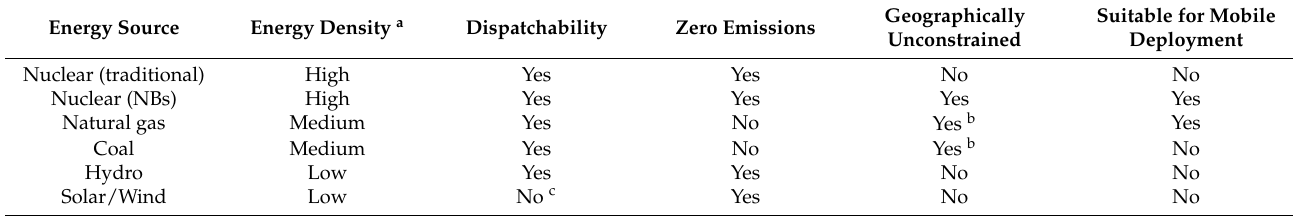
Table 1. Energy source features for the 21st century energy